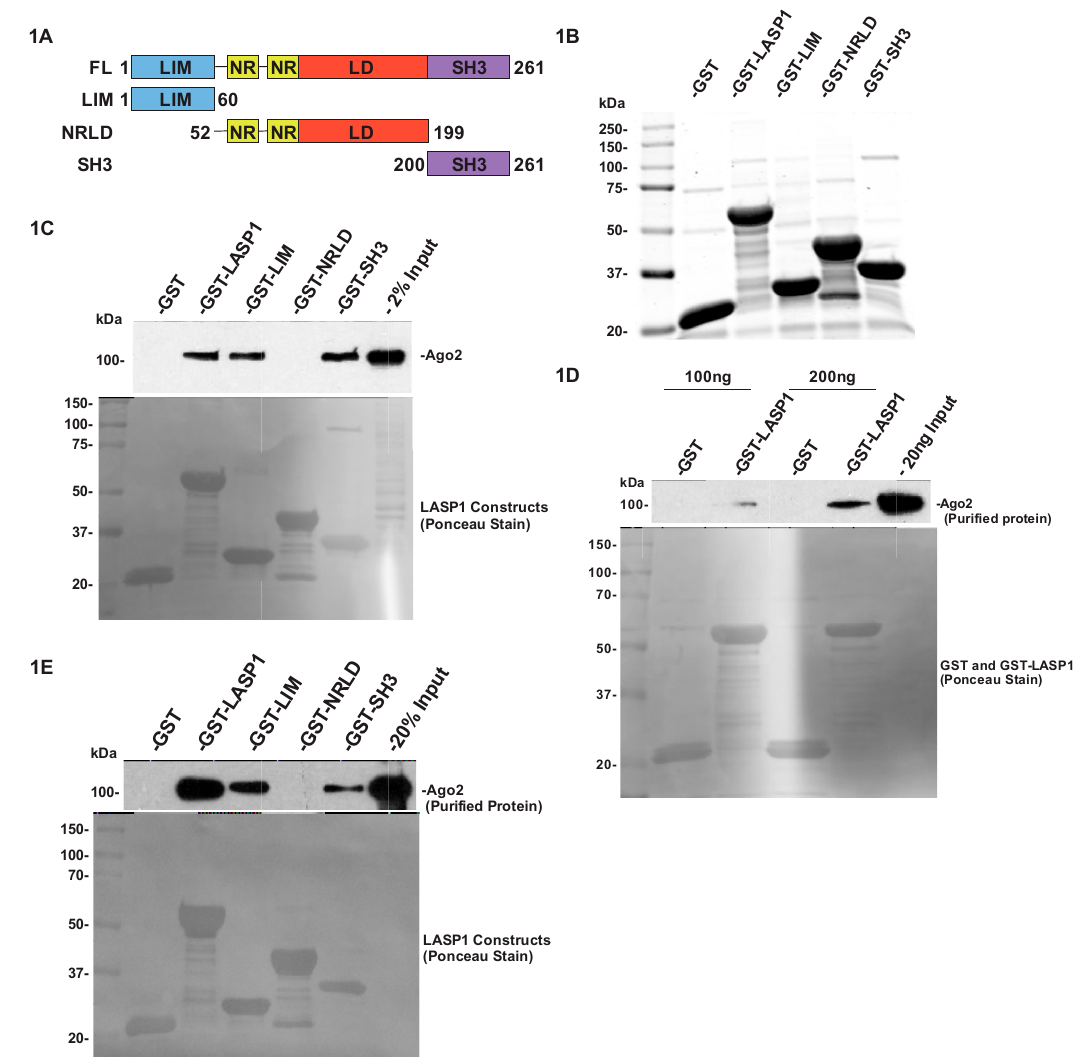
Figure 1. LASP1 directly binds to Ago2. ( A ) Schematic diagram of GST-LASP1 and its domains; FL: Full length LASP1 including all residues 1–261; LIM: LIM domain including residues 1–60; NRLD: Nebulin repeats and linker domain including residues 51–199; SH3: SH3 domain including residues 200–261. ( B ) Imperial Blue Protein Stain of 1.5 nmol of purified GST, GST-LASP1 and its domains separated by 10% SDS-PAGE. ( C ) GST-pulldown of Ago2: 1 mg of 231S lysate was incubated with 1.5 nmol of each GST-tagged protein. Association of endogenous Ago2 was detected by Western blotting and presence of proteins validated by Ponceau S Stain ( n = 3). ( D ) Direct binding of Ago2 to LASP1: 100 ng or 200 ng of purified recombinant Ago2 was incubated with 1.5 nmol of GST or GST-LASP1. Direct binding of recombinant Ago2 was detected via Western blotting and loading of proteins validated by Ponceau S Stain ( n = 1). ( E ) Direct binding of Ago2 to LASP1 domains: 100 ng of purified recombinant Ago2 was incubated with 1.5 nmol of each GST-tagged protein. Direct binding of recombinant Ago2 to different domains of LASP1 was detected by Western blotting and loading of proteins was validated by Ponceau S Stain ( n = 3). Uncropped version of the Western Blots is present in Figure S4.